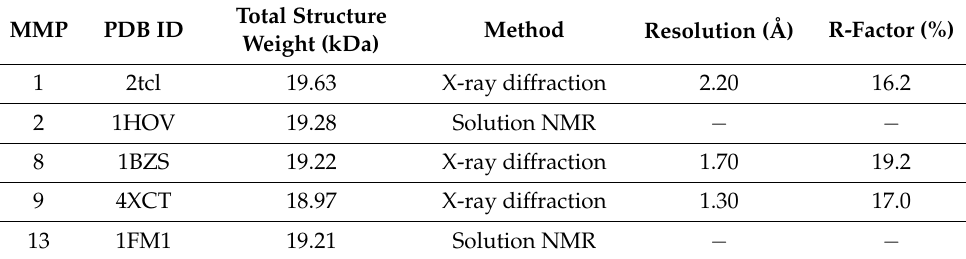
Figure 1. Compounds selected from docking studies. ( a ) N-Isobutyl-N-(4-methoxyphenylsulfonyl)glycyl hydroxamic acid- NNGH, inhibitor of commercial MMP enzymatic test kit ( b ) 4 ′ -cyano-[1,1 ′ -bihenyl]-4-yl methacrylate- Compound A [42] ( c ) 5-((4 ′ -cyano-[1,1 ′ -biphenyl]-4-yl)oxy)pentyl methacrylate- Compound B [42] ( d ) N,N ′ -(oxybis(4,1-phenylene))bis(2-methylacrylamide)- Compound C [42] . Table 1. MMP information obtained from the Protein Data Bank (PDB).